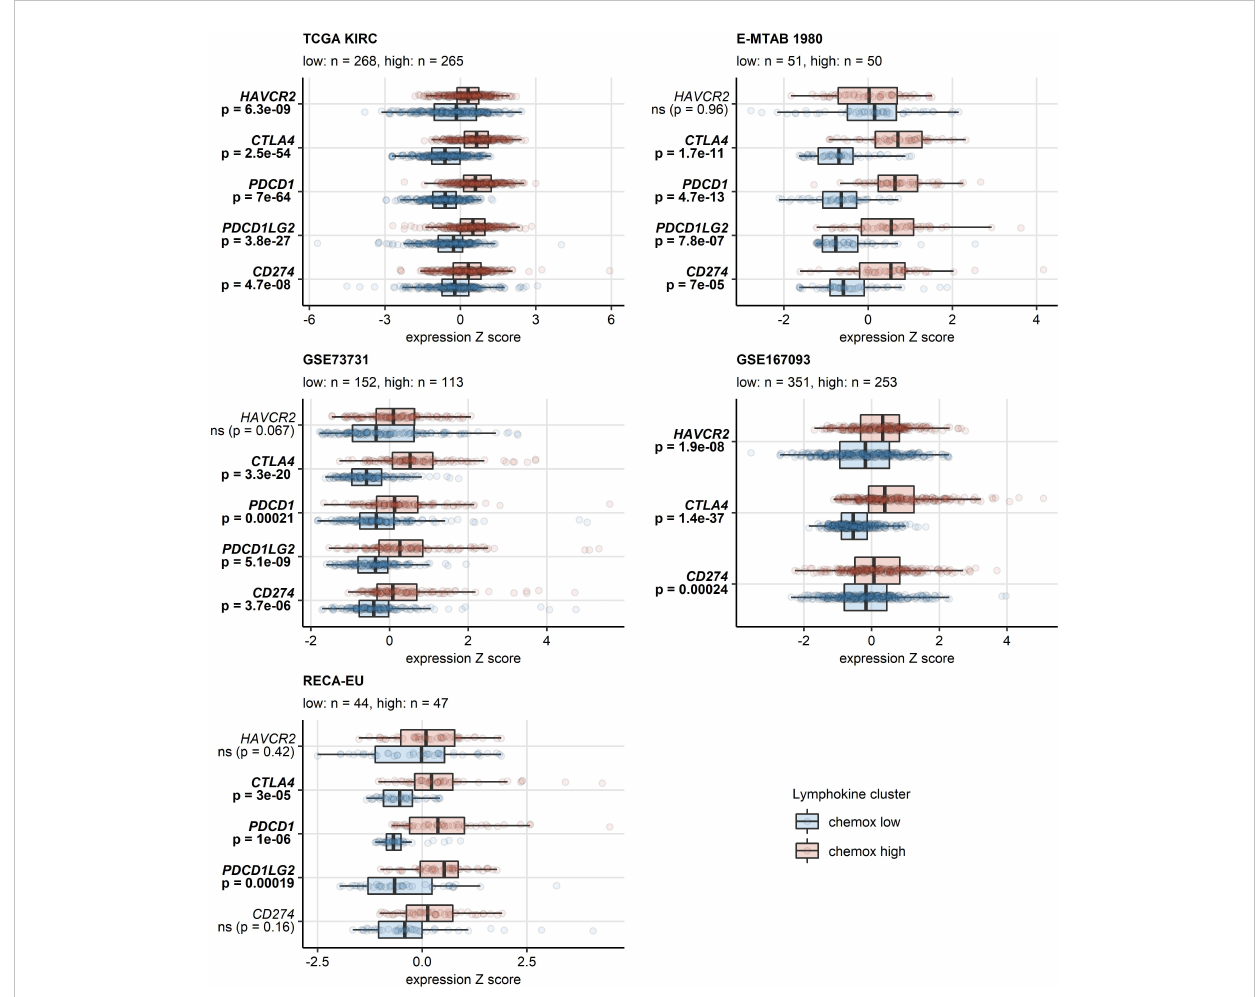
FIGURE 8 Differential expression of genes coding for clinically relevant immune checkpoint proteins in the two chemokine clusters. Genes differentially expressed in chemokine (chemox) high versus chemokine low RCCs were identi fi ed by false discovery rate (FDR) corrected two-tailed T test in the TCGA KIRC, E-MTAB 1980, GSE73731, GSE167093, RECA-EU collectives. Results for clinically relevant immune checkpoint genes are presented. Median normalized log 2 expression levels with interquartile ranges (IQR) are presented as boxes, whiskers span over the 150% IQR. Points represent single cancer samples. P values are indicated in the Y axes, signi fi cant effects are highlighted in bold. Numbers of cancer samples assigned to the chemokine high and chemokine low clusters are displayed in the plot